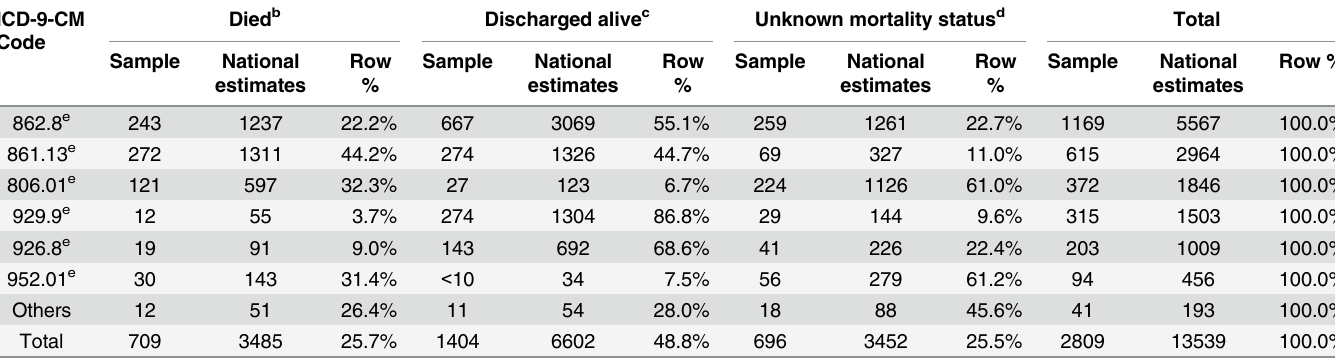
Table 4. ISS 75 patients ’ primary diagnosis codes by mortality status, NEDS 2006 – 2010 a